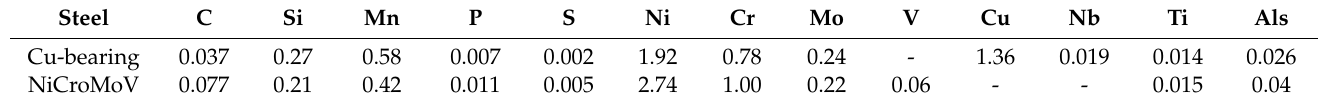
Table 1. Chemical compositions of the Cu-bearing age-hardening steel and NiCrMoV steel (mass, %). Steel C Si Mn P S Ni Cr Mo V Cu Nb Ti Als Cu-bearing 0.037 0.27 0.58 0.007 0.002 1.92 0.78 0.24 - 1.36 0.019 0.014 0.026 NiCroMoV 0.077 0.21 0.42 0.011 0.005 2.74 1.00 0.22 0.06 - - 0.015